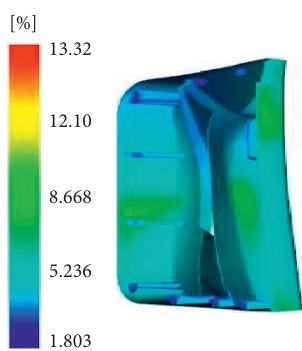
Figure 29: Volume shrinkage